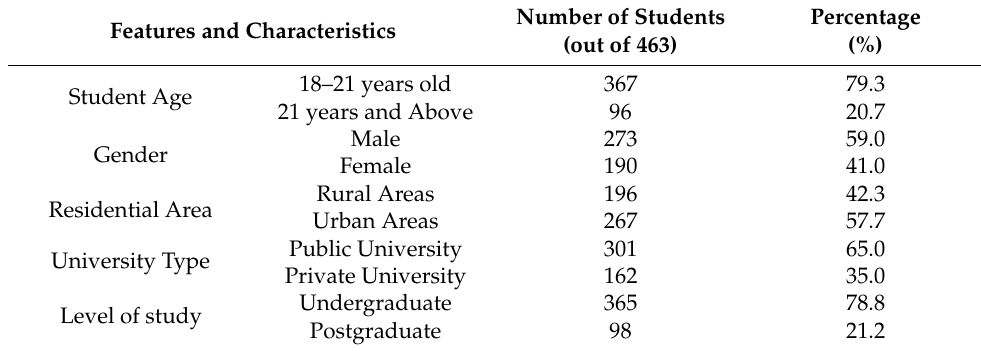
Table 1. Study participants demographic features and characteristics.